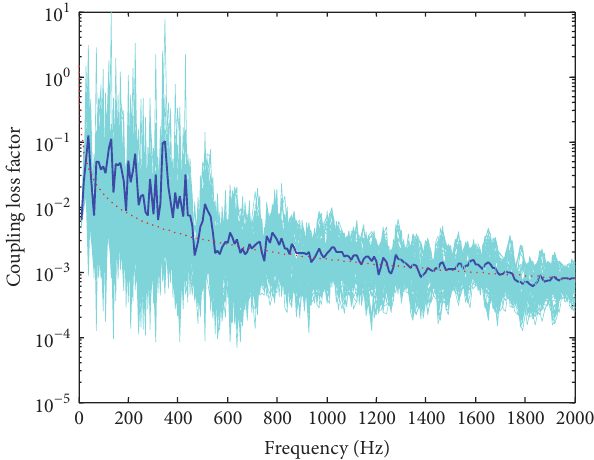
Figure 5: Comparison of 𝜂 12 when 𝑁 = 1 : PIM simulations (real thin lines); ensemble average of the PIM solutions (thick real line); (43) (dotted